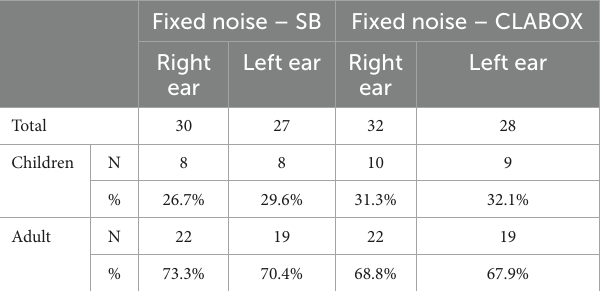
TABLE 3 Characterisation of participants by number of ears that were unable to perform the HINT. Fixed noise –